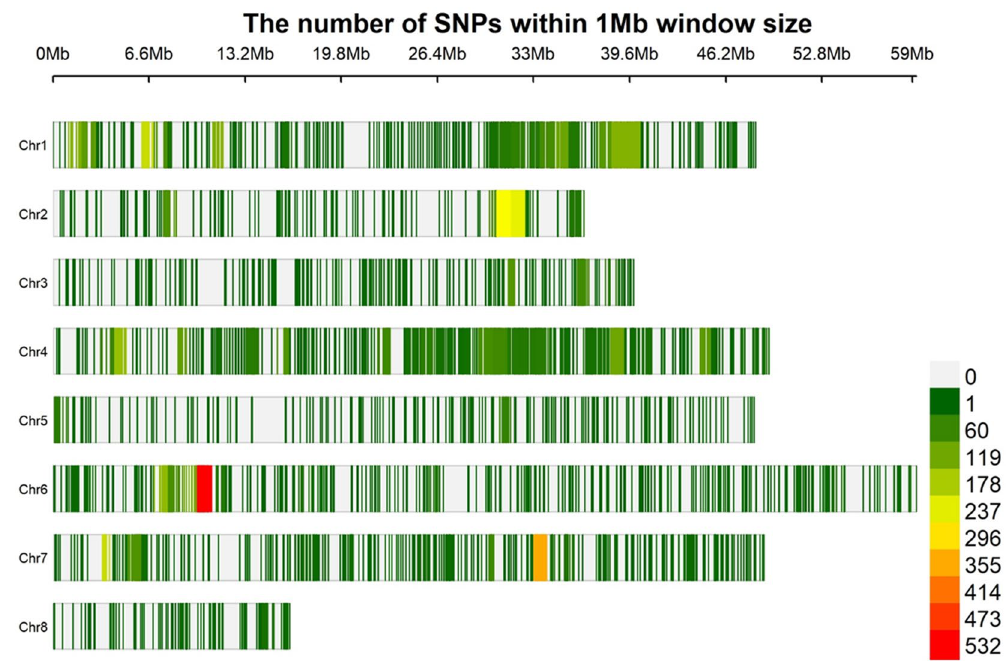
Figure 2. Distribution of 7277 high-quality SNPs over 8 different chickpea chromosomes. The figure shows the number of SNPs within 1 Mb window and reflects the SNP density on each chromosomes used during the present study for GWAS for micronutrients.